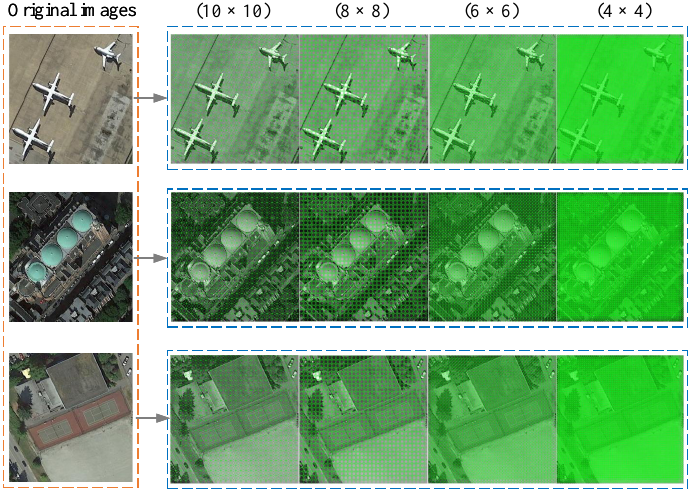
Figure 2. An illustration of different patch sizes. Given a remote sensing image, the BoW model is designed with different image patch sizes to incorporate spatial information. Left column: Example images from NWPU dataset. Right columns: SURF [31] features of light, medium and dark green colors represent different spatial